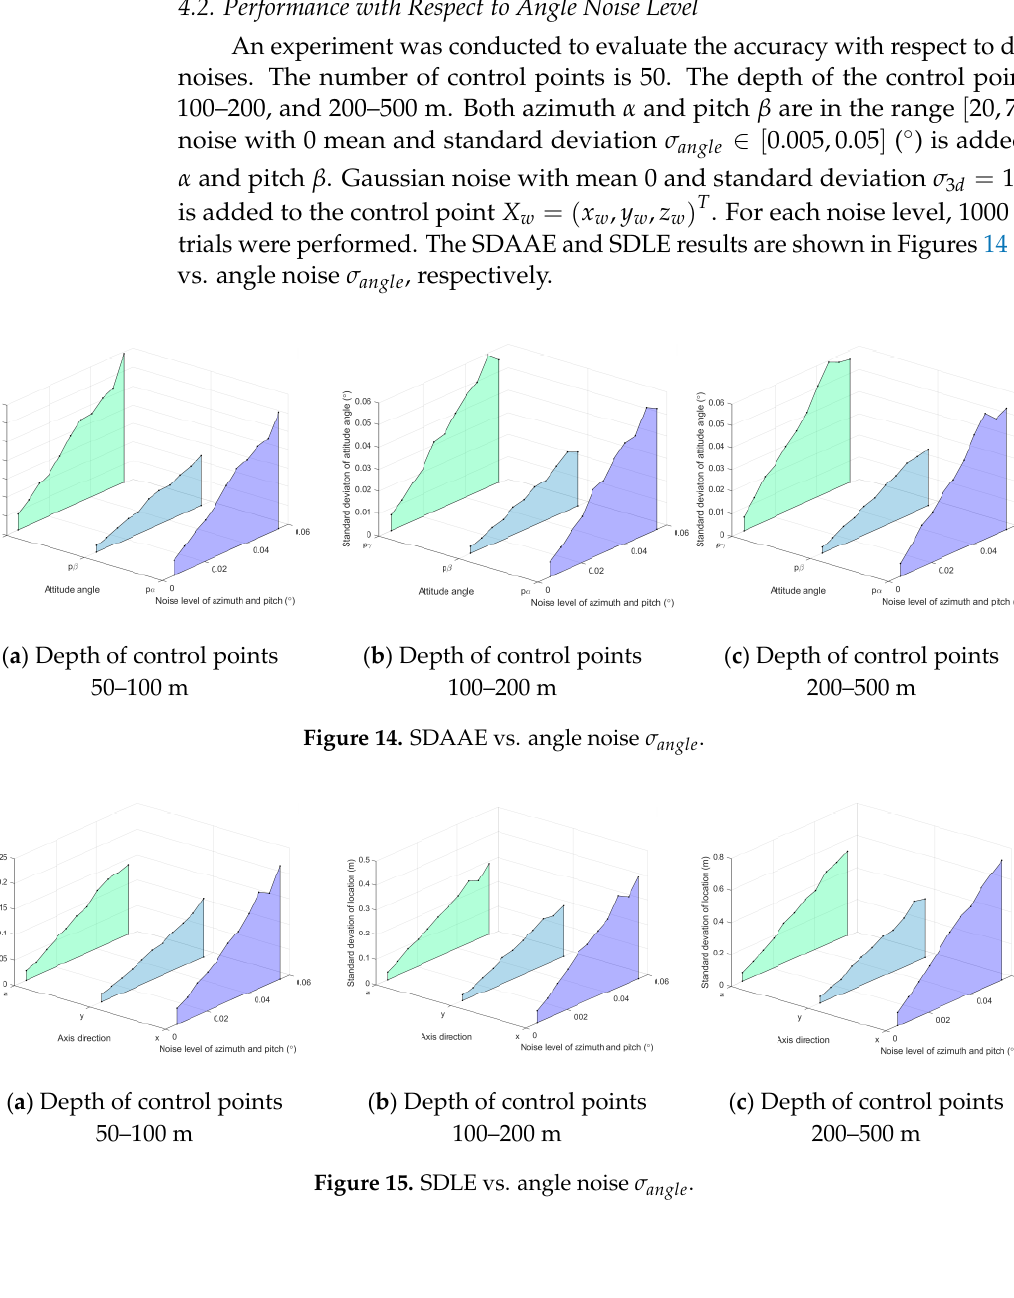
Figure 13. SDLE vs. number of control points.